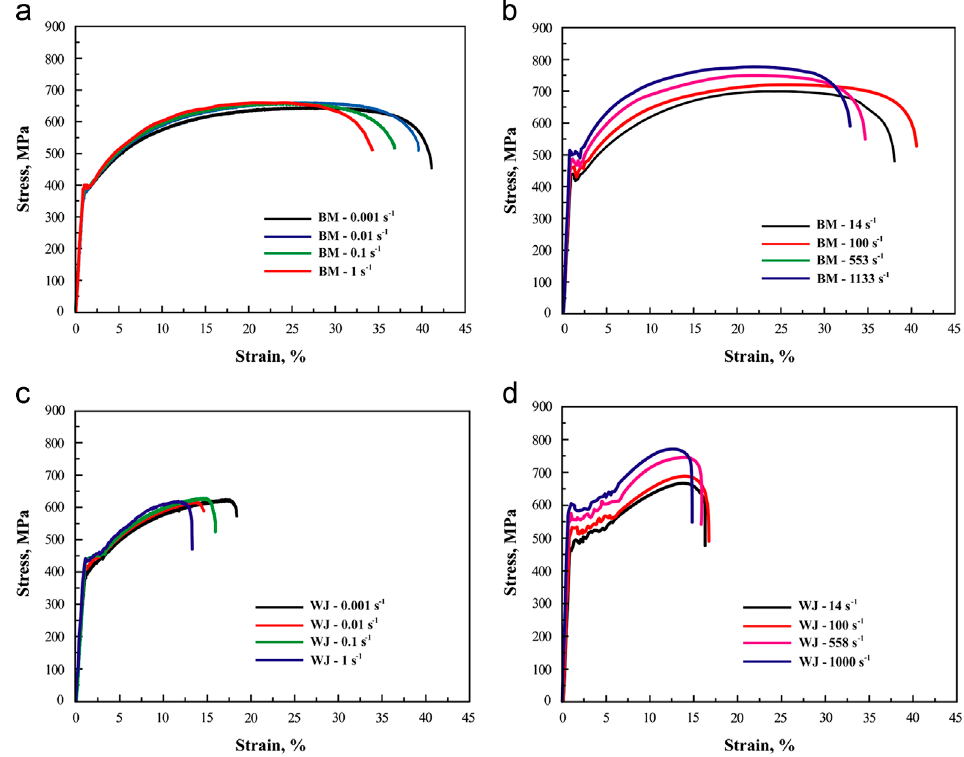
Figure 29. Stress–strain curves for ( a ) DP600 base metal (BM) tested at strain rates from 0.001 to 1 s − 1 , ( b ) DP600 BM tested at strain rates from 14 to 1133 s − 1 , ( c ) DP600WJ tested at strain rates from 0.001 to 1 s − 1 , and ( d ) DP600 WJ tested at strain rates from 14 to 1000 s − 1 [171] .